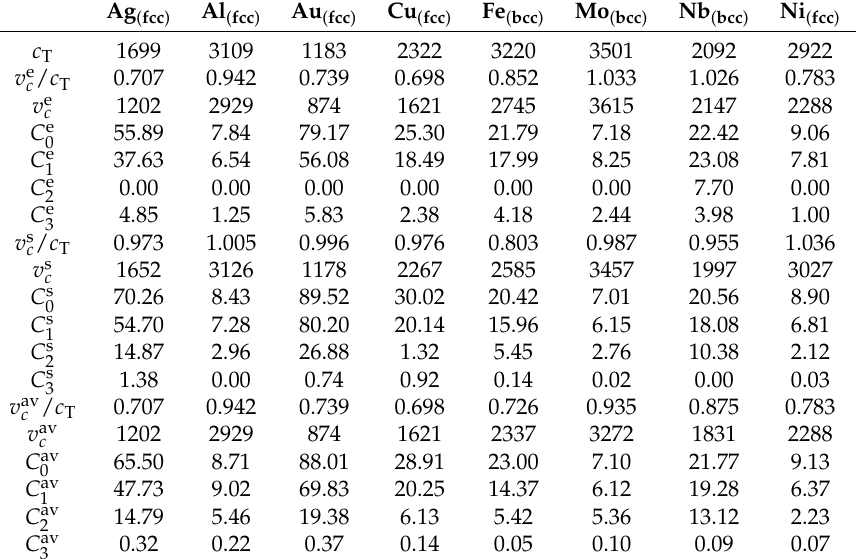
Table 3. List of critical velocities v c (m/s), and fitting function coefficients C i ( µ Pas) for some cubic crystals. The critical velocities are given in units of m/s as well as in ratio to c T . The fits are only valid up to 0.99 c T and do not capture the asymptotic behavior for those metals/dislocations whose critical velocity is larger than this value. Superscripts “e”, “s”, and “av” refer to “edge”, “screw”, and “average”, respectively. Furthermore, v av c coincides with the smallest critical velocity for all dislocation characters ϑ within the slip system.